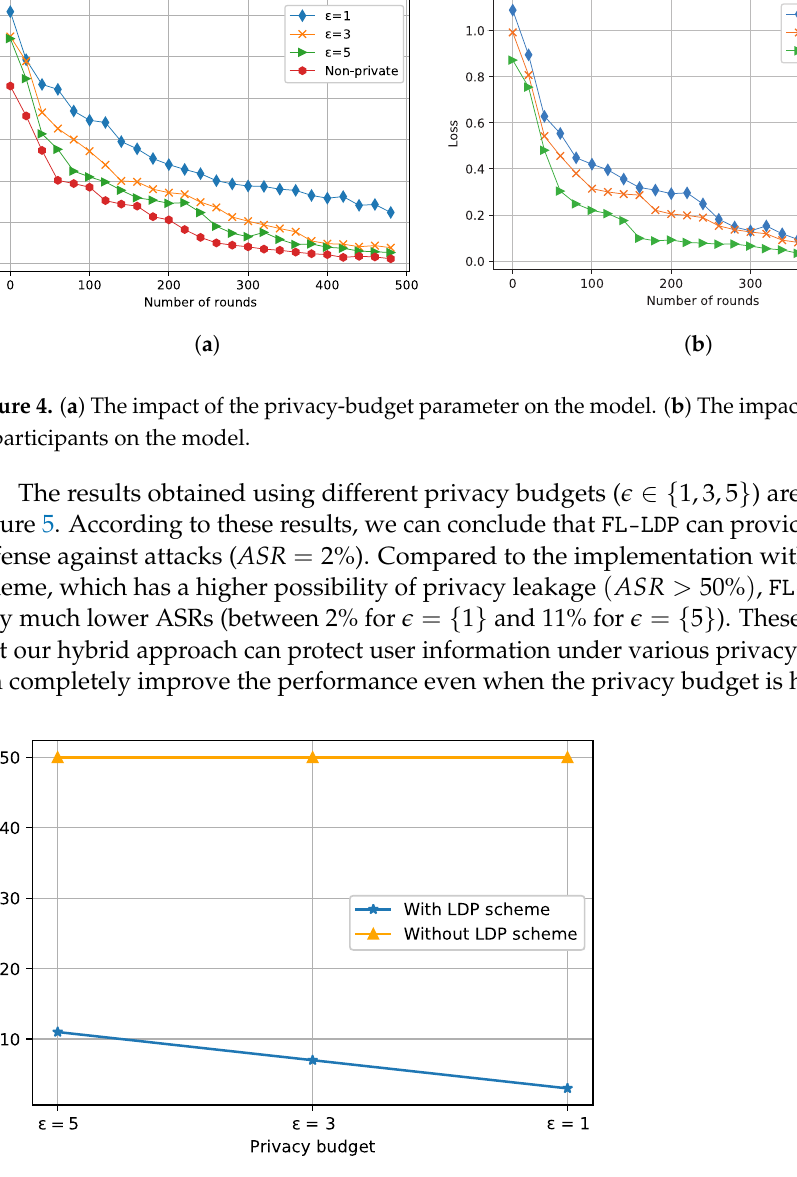
Figure 5. The impact of privacy budgets on the attack-success-rate